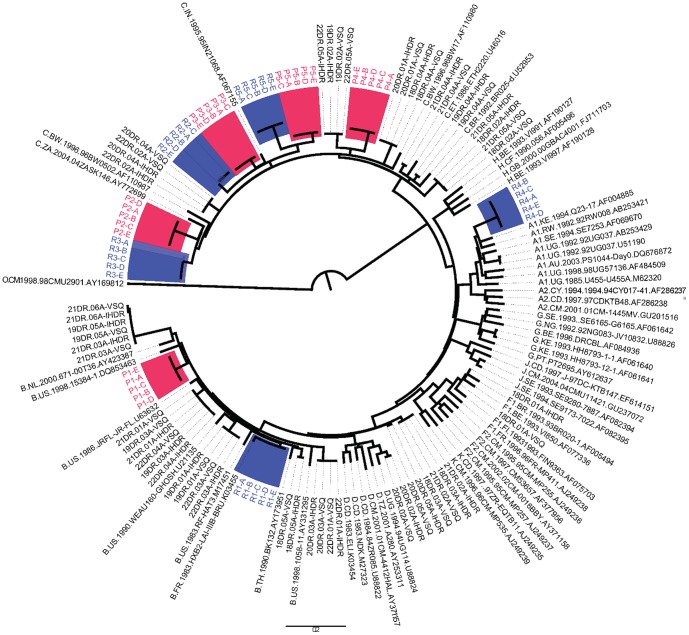
Phylogenetic analysis of the sequences generated during the evaluation of an in-house method.The phylogenetic tree was generated by using the PhyML software to create a maximum likelihood tree [13]. The reference sequences were obtained from the Los Alamos HIV Database (www.hiv.lanl.gov). IHDR- sequences generated by an in-house method; VSQ- sequences generated by the ViroSeq method; R1 to R5- sample used in the reproducibility study (hilighted in blue); P1 to P5- sample used in the precision study (hilighted in red); A, B, C, D, E are the replicates of the same sample.